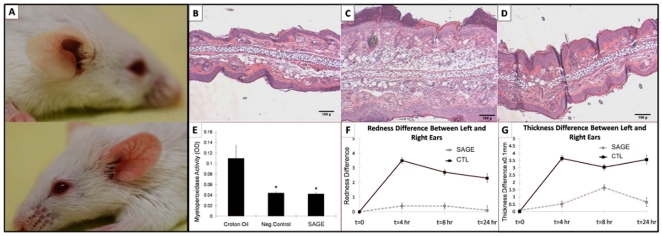
Topical SAGE reduces ear edema from croton oil.GM-1111 (1%) was applied topically in the croton oil model. A. Normal control right ear (top) and croton oil painted left ear (bottom). B. H&E section of control normal ear. C. H&E-stained cross-sectional view of a croton oil painted ear with vehicle treatment. D. H&E-stained cross-sectional view of croton oil painted ear with SAGE treatment. E. MPO activity measurement in ears. F. Ear thickness differences between left (croton oil) and right (normal) ears. G. Redness difference between right and left ears. *P<0.05 vs croton oil with vehicle emollient alone (negative control).